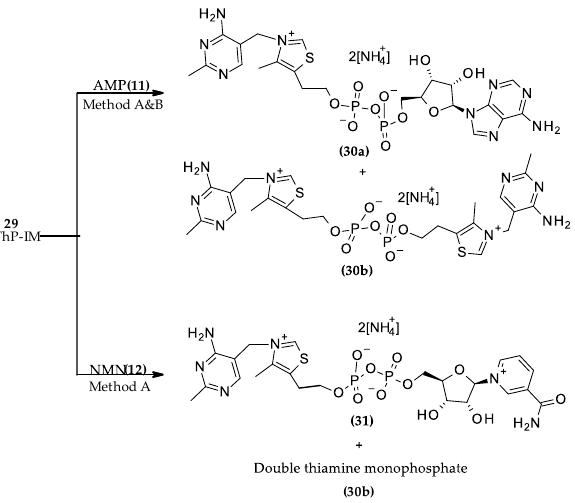
Scheme 3. Synthesis of thiamine adenosine and nicotinamide riboside pyrophosphates ( 30a and 31 and dithiamine pyrophosphate ( 30b ).